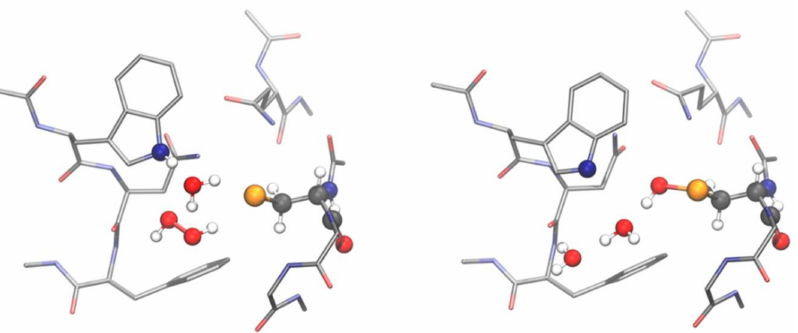
Figure 3. Stationary points along the PES of the GPx4 active site for the mechanism of oxidation of Sec by H 2 O 2 : zwitterionic intermediate ( left ) and selenenic acid ( right ). The fragments directly involved in the mechanism are shown in balls and sticks representation, while the remaining residues are shown in licorice representation and H atoms are omitted for clarity. Level of theory: SMD-B3LYP- D3(BJ)/6-311+G(d,p), cc-pVTZ//B3LYP-D3(BJ)/6-311G(d,p), cc-pVTZ